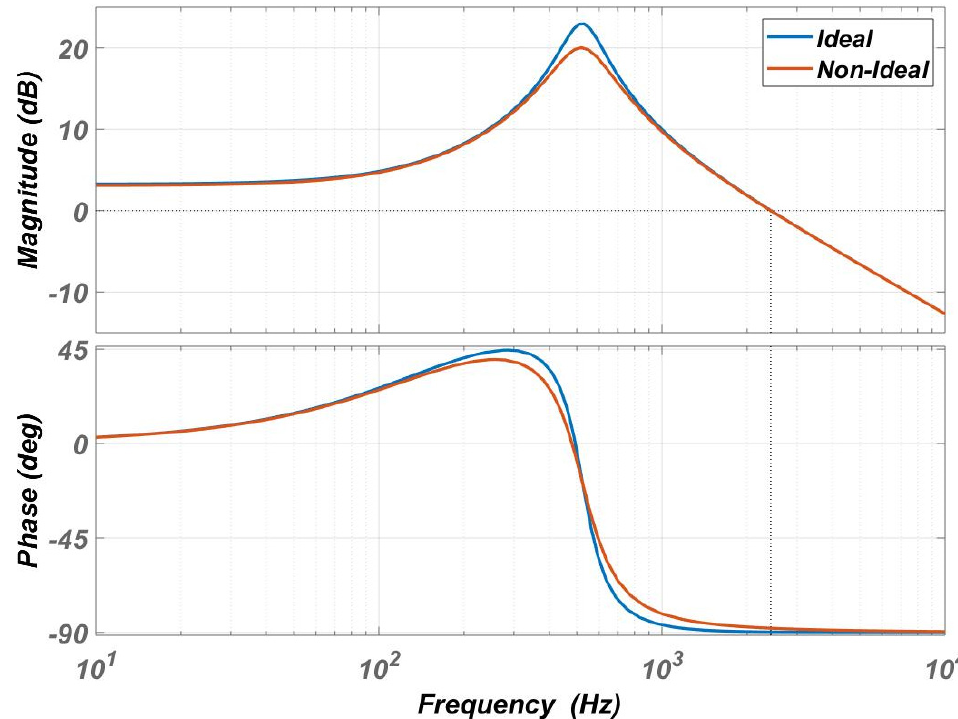
Figure 9. Bode plot of G id for ideal and non-ideal synchronous buck converters.